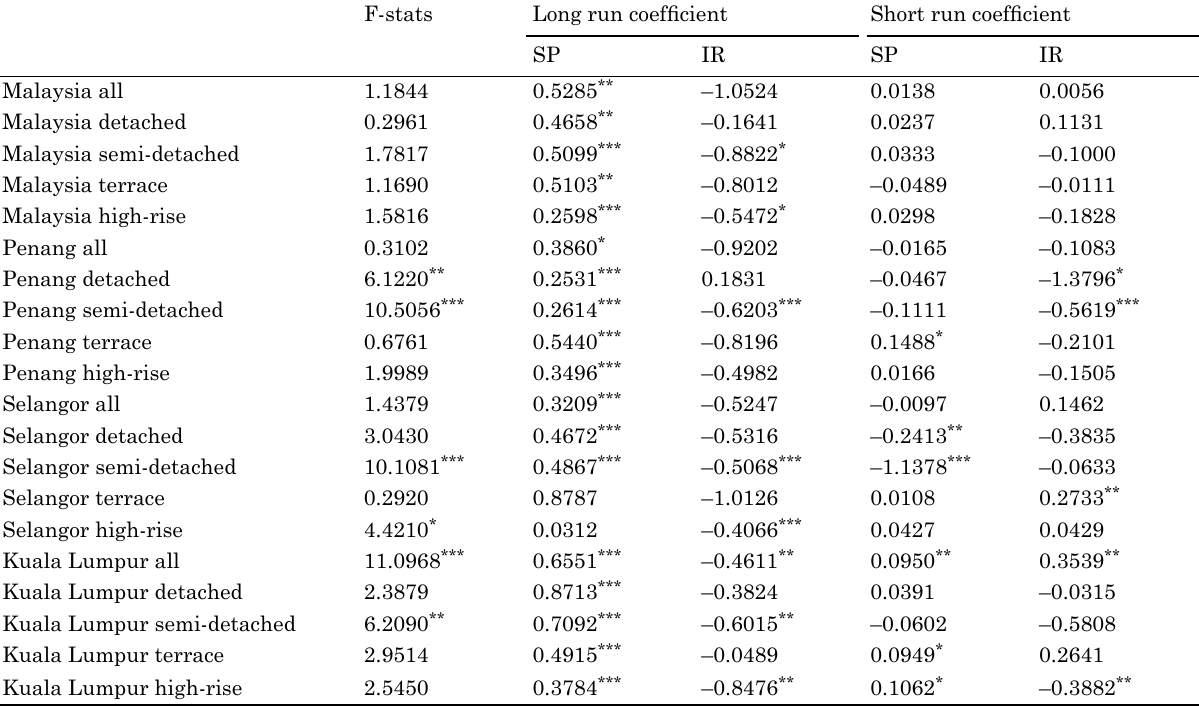
Table 3. ARDL bounds test for